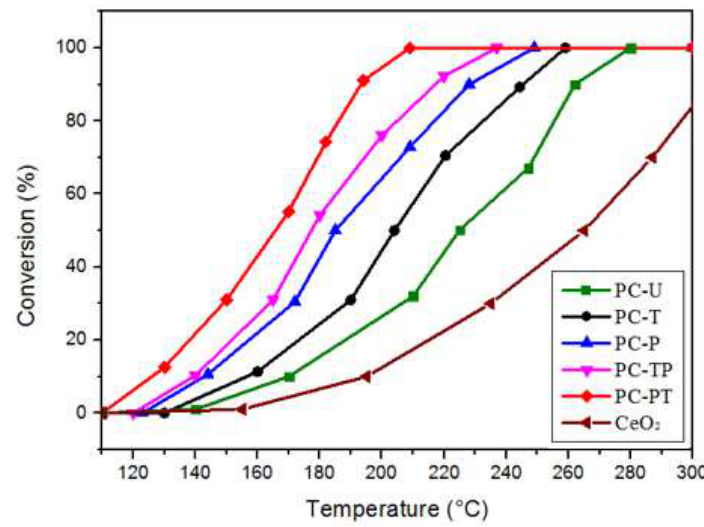
Figure 1. Conversion of toluene over catalysts with various treatment.